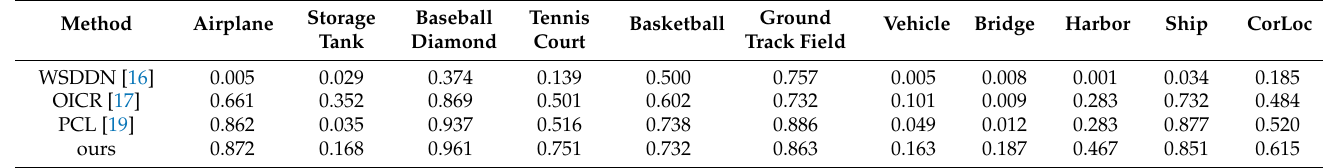
Table 3. CorLoc on the NWPU VHR-10 train